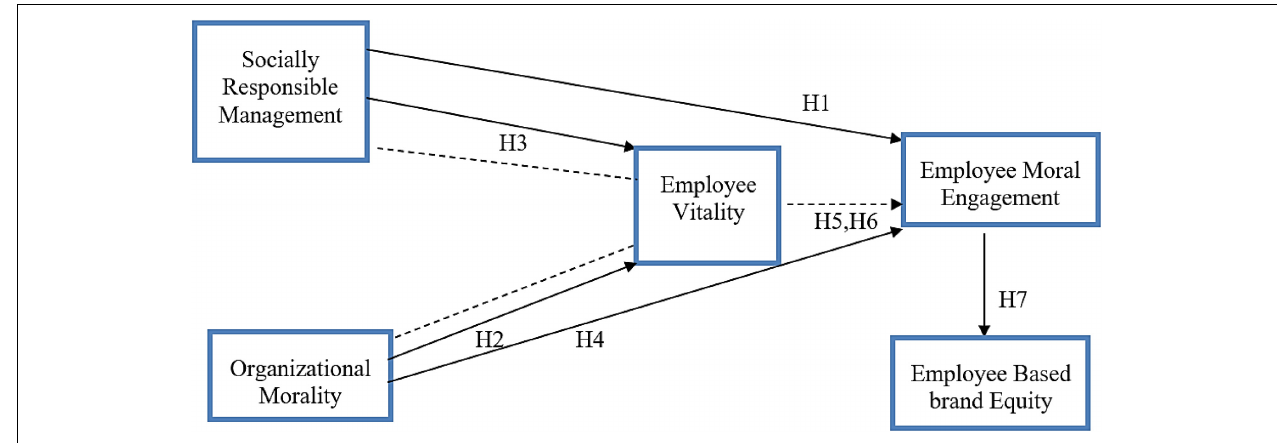
FIGURE 1 | Theoretical framework.